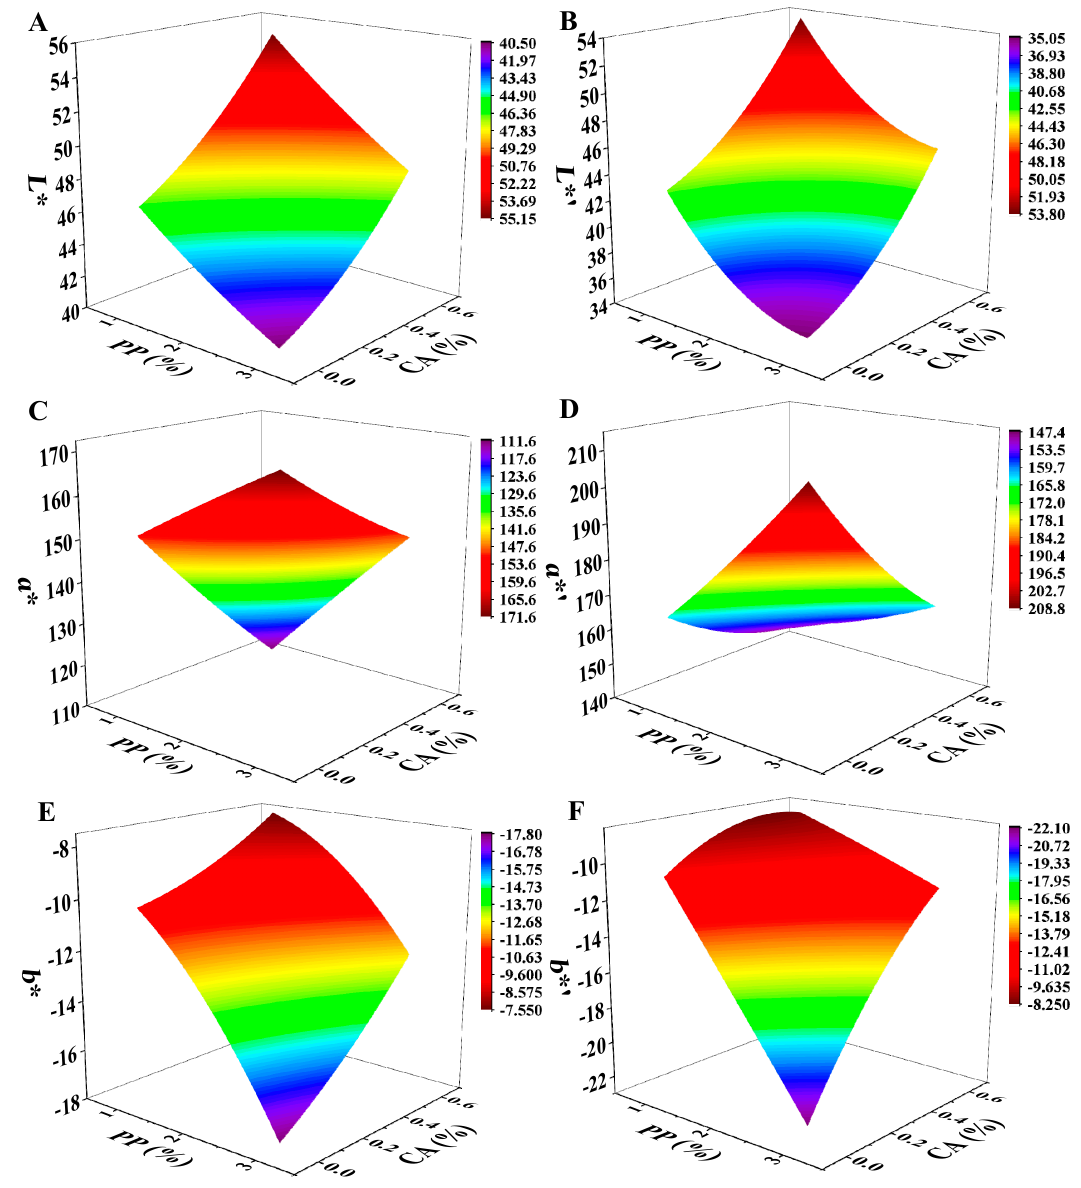
Figure 11. Correlation analysis data charts: ( A − F ) are the nonlinear surface fitting of L *, a *, b *, L * (cid:48) , a * (cid:48) , and b * (cid:48) to PP and CA, respectively. L *, a *, and b * are the colour indexes of mackerel mince before heat treatment and L * (cid:48) , a * (cid:48) , and b * (cid:48) are the colour indexes of mackerel mince after heat treatment.